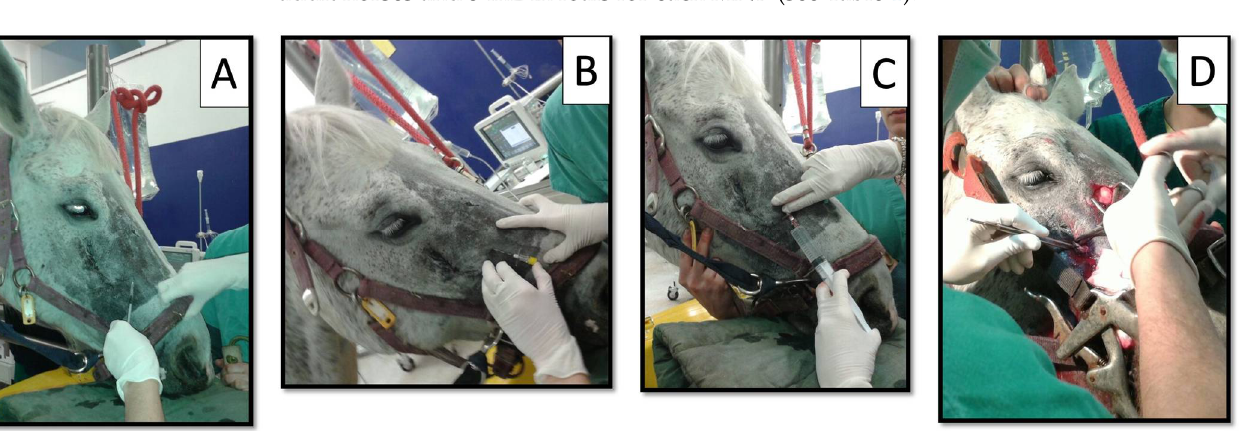
Figure 3. July 2016: a 38-day old foal in group GEN undergoing bilateral rhinoplasty for nasal sep- tum fracture. Two 22 G × 5 cm Tuohy needles were inserted at the right ( A ) and left ( B ) infraorbital canal for bilateral block of the maxillary nerve.